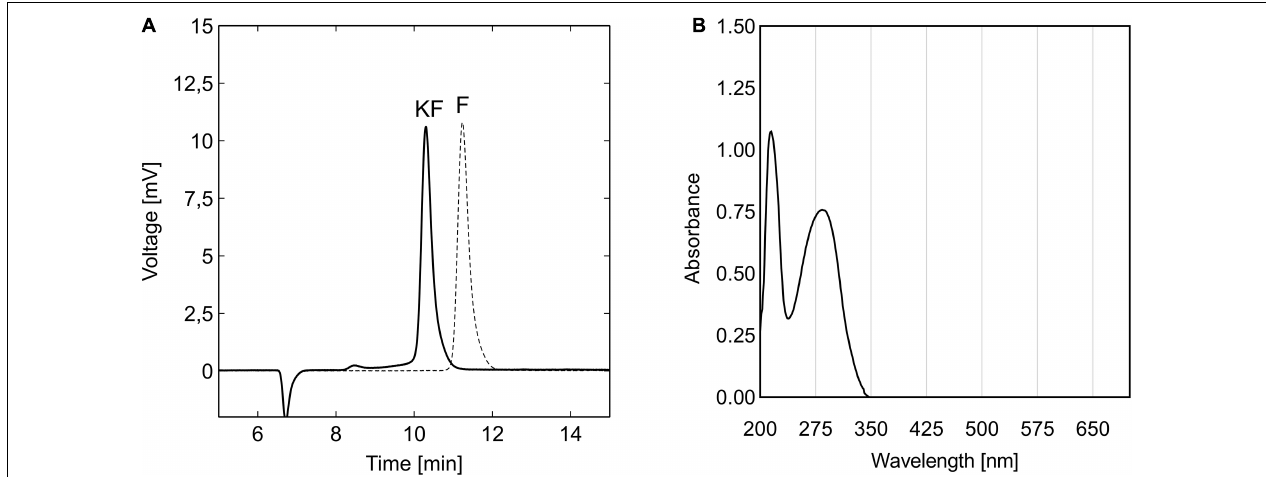
FIGURE 1 | HPLC chromatograms of 5-KF and D -fructose solutions (A) and UV-Vis spectrum of 5-KF (B) produced by resting cells of G. Gluconobacter oxydans 621H strains. After bioconversion of 200 mM D -fructose solution with G. oxydans fdh and G. oxydans 621H and subsequent downstream processing, final process solutions were analyzed by HPLC and UV-Vis spectroscopy. Chromatographic separation of 5-KF solution (solid line) and D -fructose solution (dotted line) was achieved using the Eurokat H column (300 × 8 mm; Knauer GmbH) heated to 65 ◦ C. The mobile phase, 5 mM H 2 SO 4 , was applied at a flow rate of 0.6 ml min − 1 . Shown are the signals of the refractive index detector. UV-Vis spectroscopy was performed solely for 5-KF using a JASCO V-650 spectrophotometer (JASCO Deutschland GmbH).